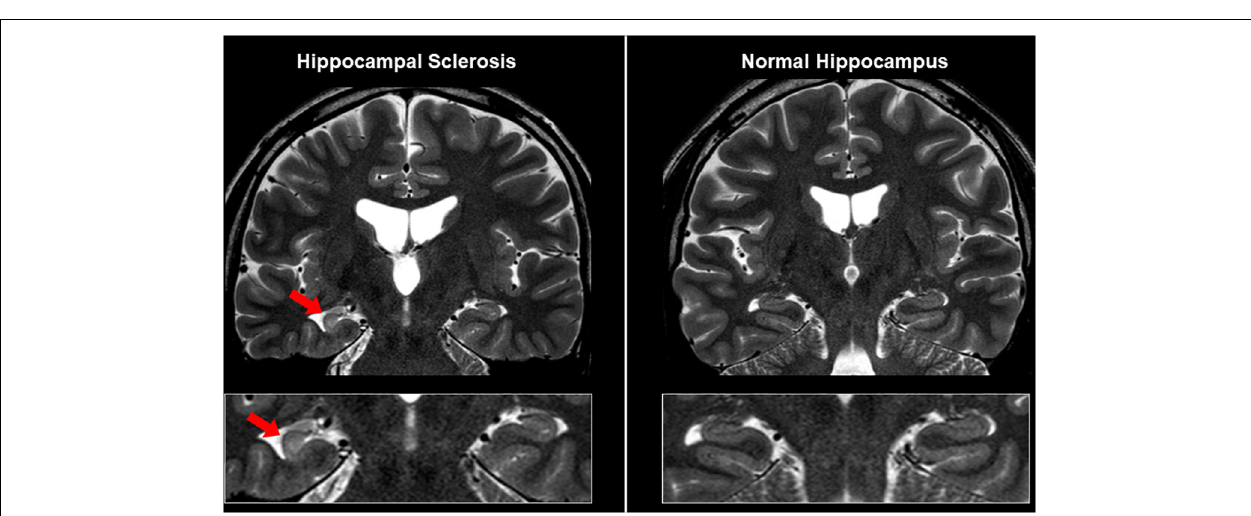
tuberous sclerosis (Shao et al., 2021). RSI is another advanced diffusion MRI using multi-shell, reduced neurite density, and its correlation with clinical symptoms in epilepsy was also